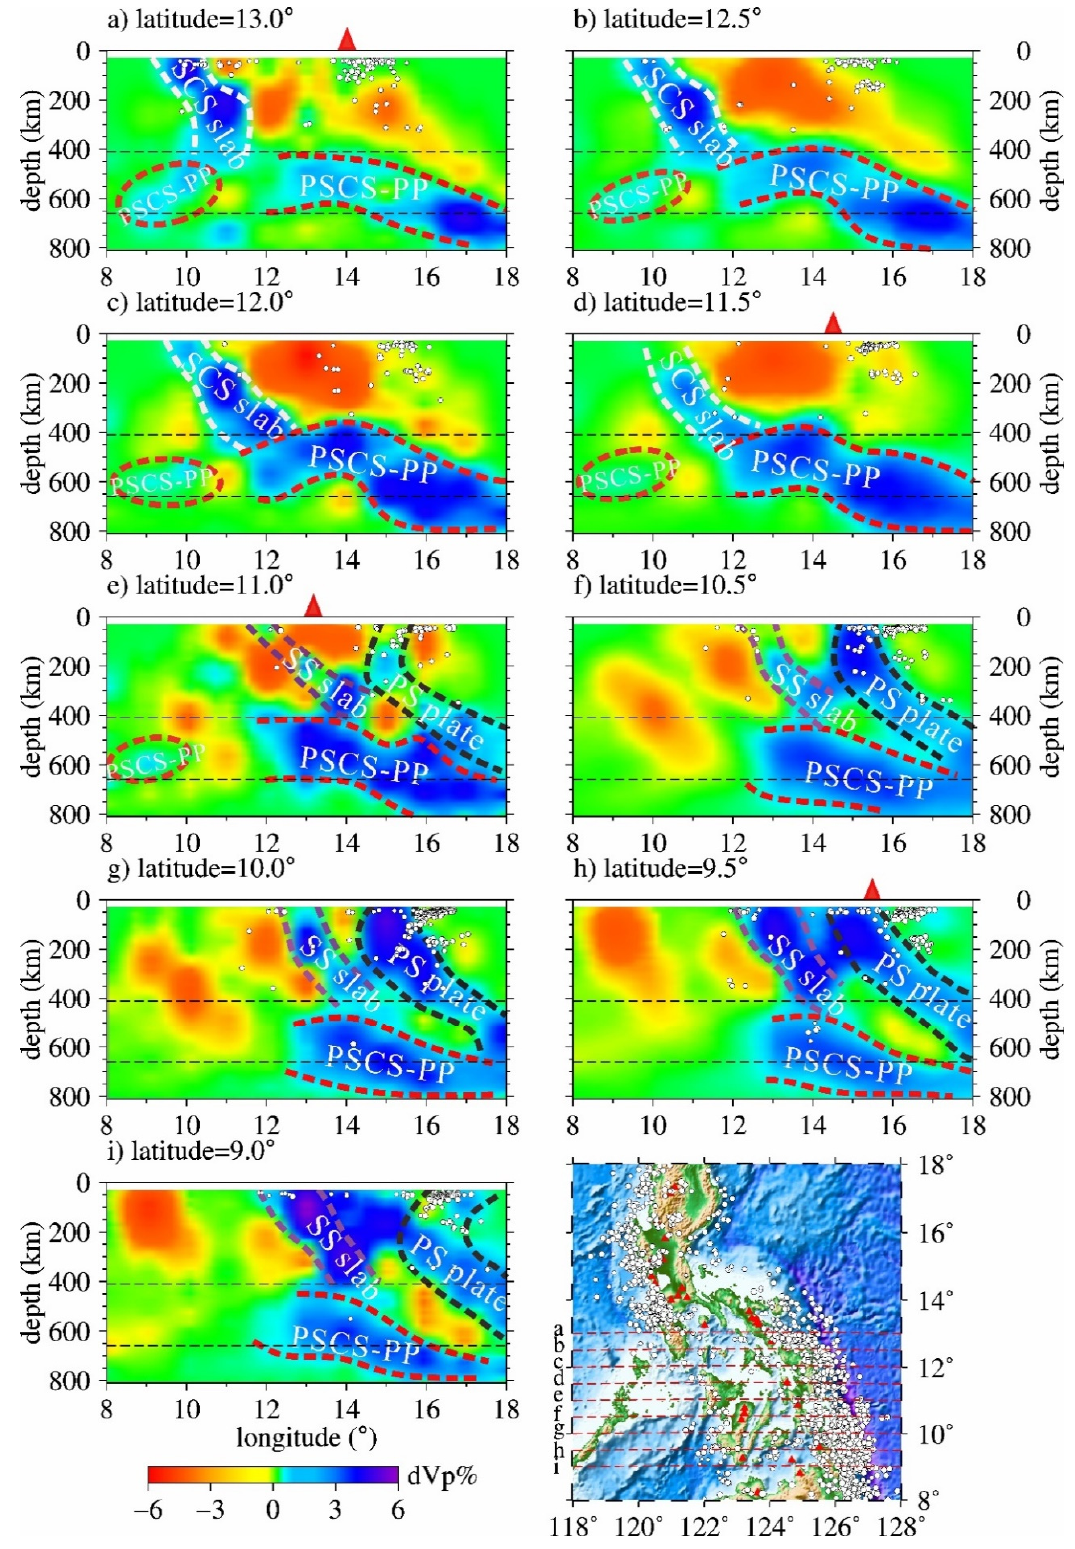
Figure 9. Nine velocity cross-sections along different latitudes. Fast anomalies are denoted by blue color, slow anomalies are denoted by red color. The color bar of the anomaly is located at the bottom. Red triangles indicate volcanoes. The two black horizontal dotted lines indicate the interfaces at 410 km and 660 km, respectively. White dots, gray dot and black dots indicate the location of source for the earthquakes occurred within 0.25° on both sides of the profile, respectively. These data were obtained from the ISC seismic catalog [23].